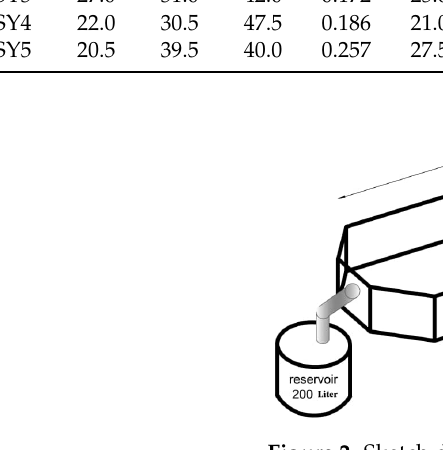
Figure 2. Sketch design for the experimental plot. Table 2. Soil texture and K value in the studied locations (SY1-SY5) for three land uses (agricultural land (AG), burnt forest (BF), and forest land (F)).